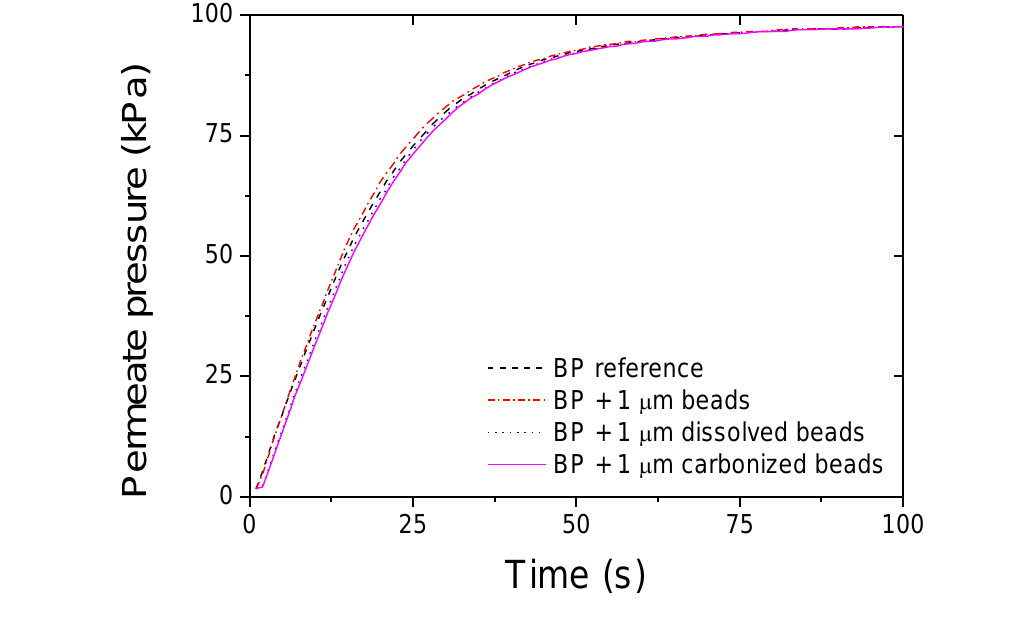
Table 1. Composite